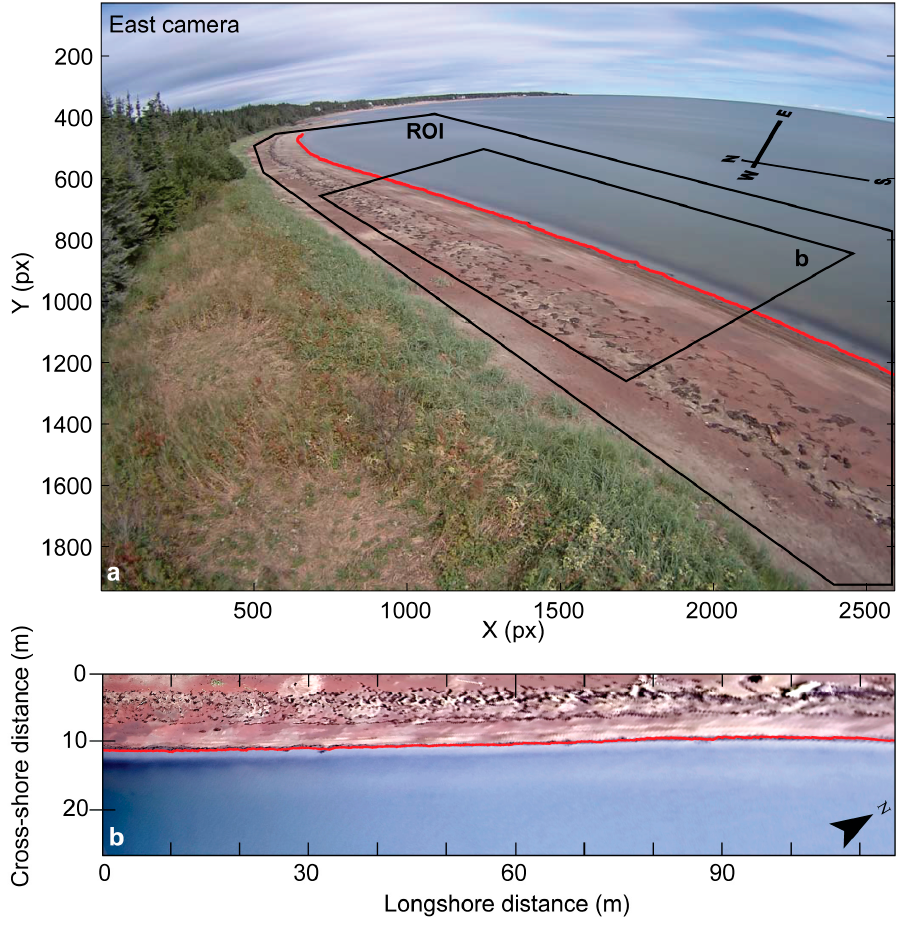
Figure 6. Time-averaged (TIMEX) image with a detected shoreline in calm conditions (red line) ( a ) and geo-rectified detected shoreline (red line) shown on a time-averaged image from the east camera of Pointe-Lebel ( b ).